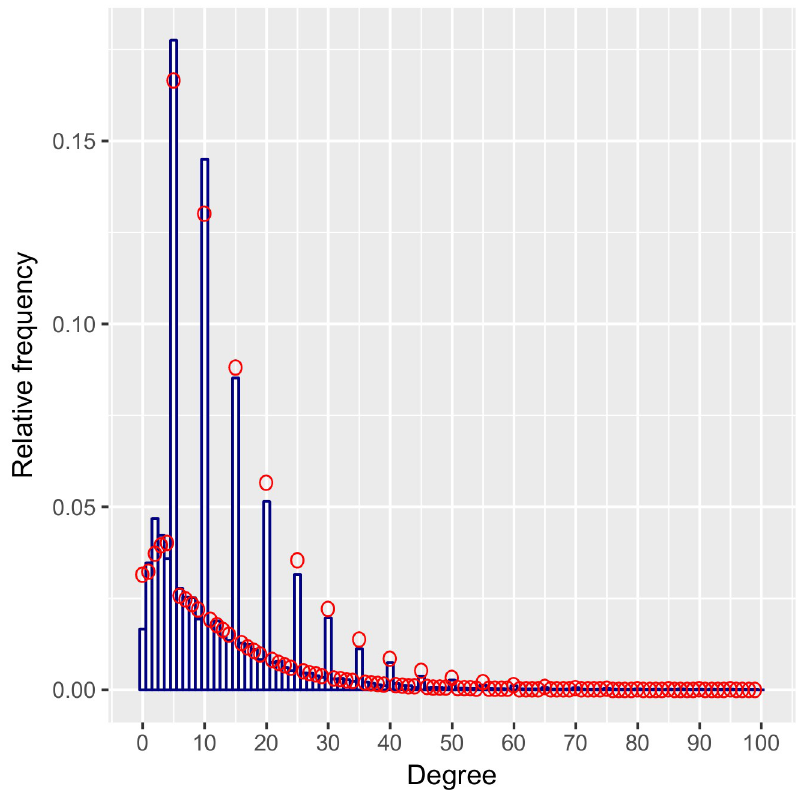
Fig 5. Histogram of multiply imputed distribution of reported degree overlaid with predicted distribution of contact reports inferred by the estimated underlying curve and estimated rounding probabilities.